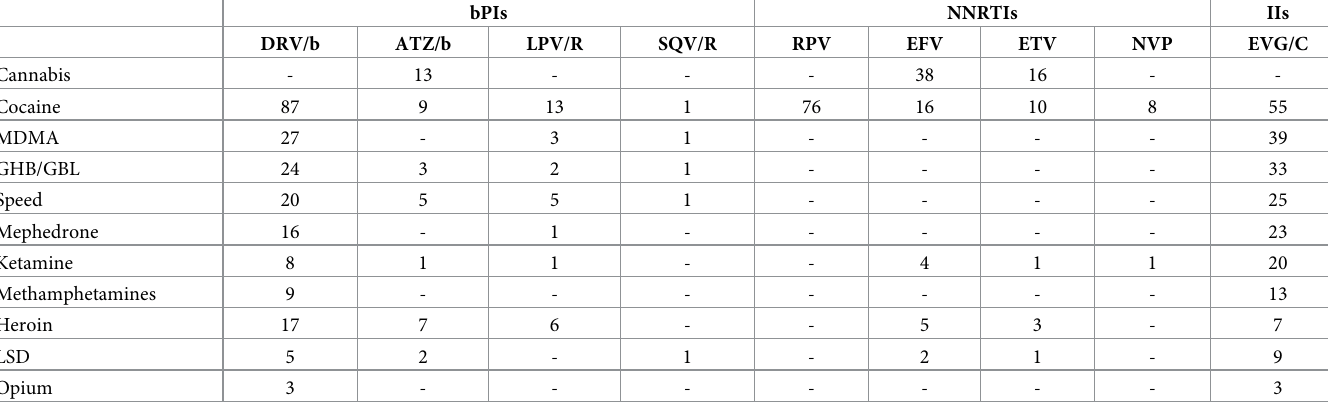
Table 2. Potential interactions between illicit drugs and antiretroviral therapy.